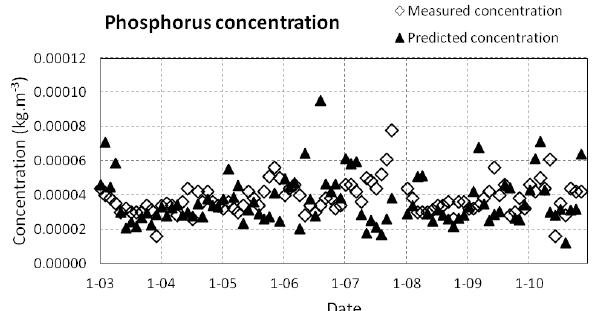
Fig. 5. Comparison of measured and predicted phosphorus concen- trations in Figure 5. Comparison of measured and predicted phosphorus concentrations in river. 2